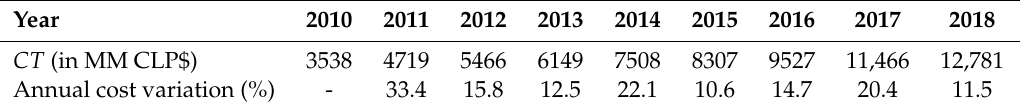
Table 2. Total annual medication purchasing, operational and storing costs ( CT ) in the HRT (MM CLP corresponds to millions of Chilean